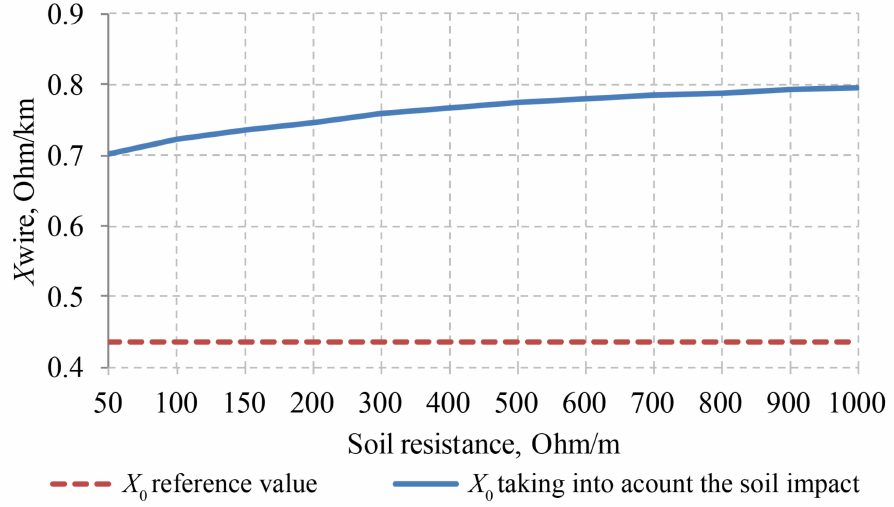
Figure 10. Relationship between the wire reactance (1 km long) and the soil resistance.